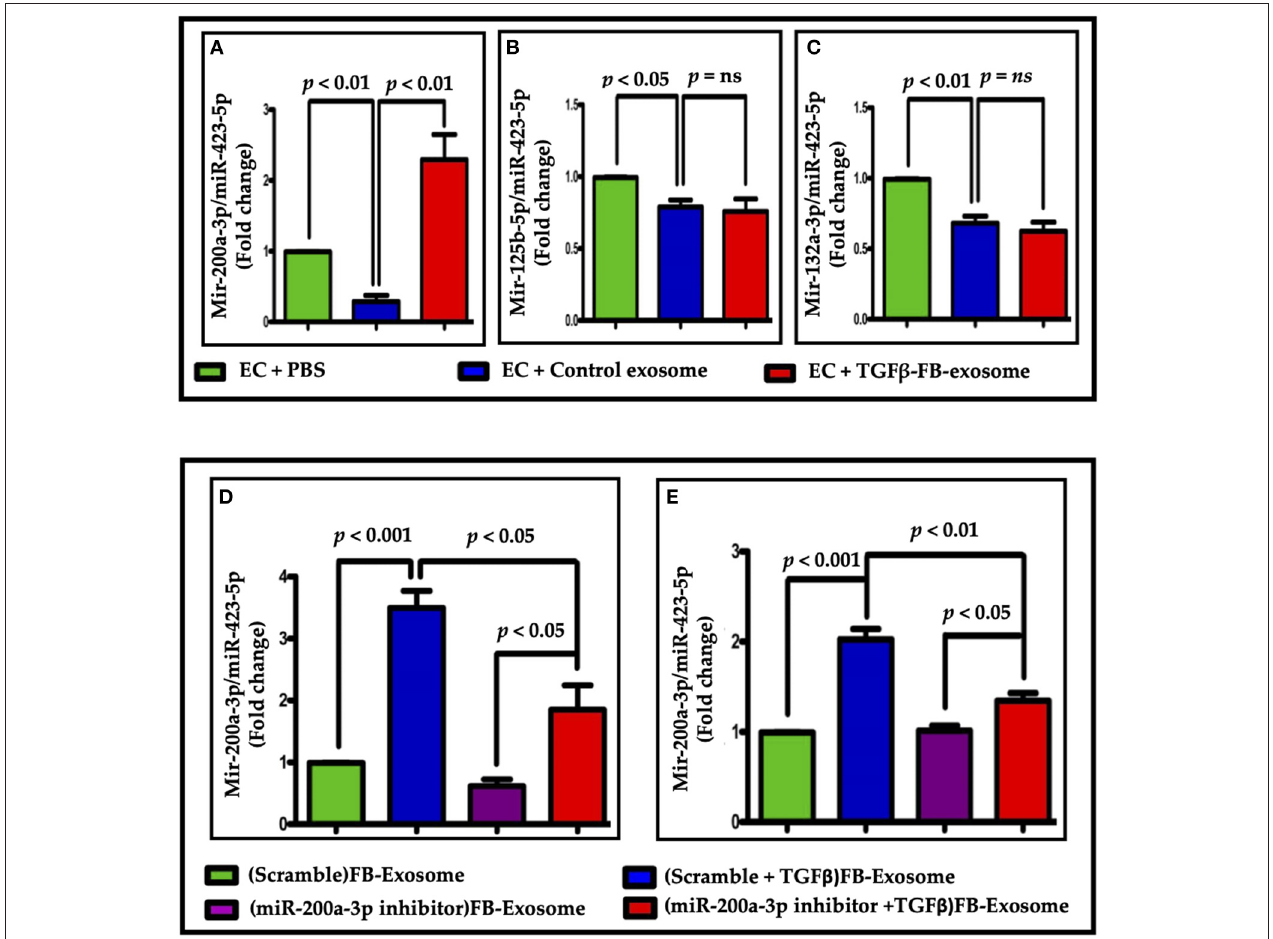
FIGURE 7 | Altered miRNA (miRNA-200a-3p) packaging was seen in myofibroblast-derived exosomes. (A–C) Altered miRNA expression was found in ECs after treatments. Only miR-200a-3p expression showed a significant difference when treated with TGF β -FB-exosomes. (D,E) Analysis of miR-200a-3p expression in exosomes (D) or EC (E) following miR200a-3p inhibition in parent cells. (E) miR-200a-3p expression was significantly reduced in endothelial cells treated with modified exosomes in comparison to Exo-TGF β treatment alone. P < 0.05 vs. control exosome and PBS treatment. “ns”, not statistically